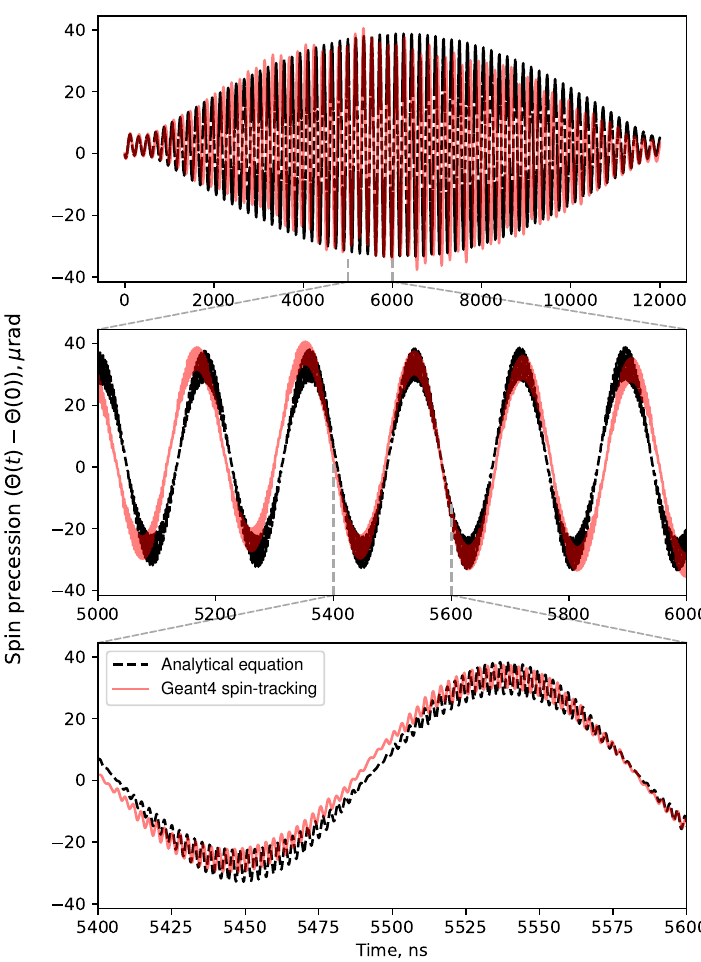
Figure 2. Comparison between the analytical equations (36) and the Geant4 spin tracking simula- tion. The initial parameters are arbitrarily set to ⃗ S 0 = ( − 0 . 89 , 0 . 00 , − 0 . 46), ⃗ p 0 = (0 . 84 , 0 . 00 , 0 . 55) × 26 . 8 MeV / c and ⃗ r 0 = ( − 16 . 95 , 5 . 00 , 22 . 10) mm. The ideal momentum for which the freeze field is set = 28 . 0 MeV / c. The three subfigures show di ff erent timescales of the spin motion – uncompen- is p (ideal) 0 sated ( g − 2) precession, betatron oscillations and cyclotron oscillations.